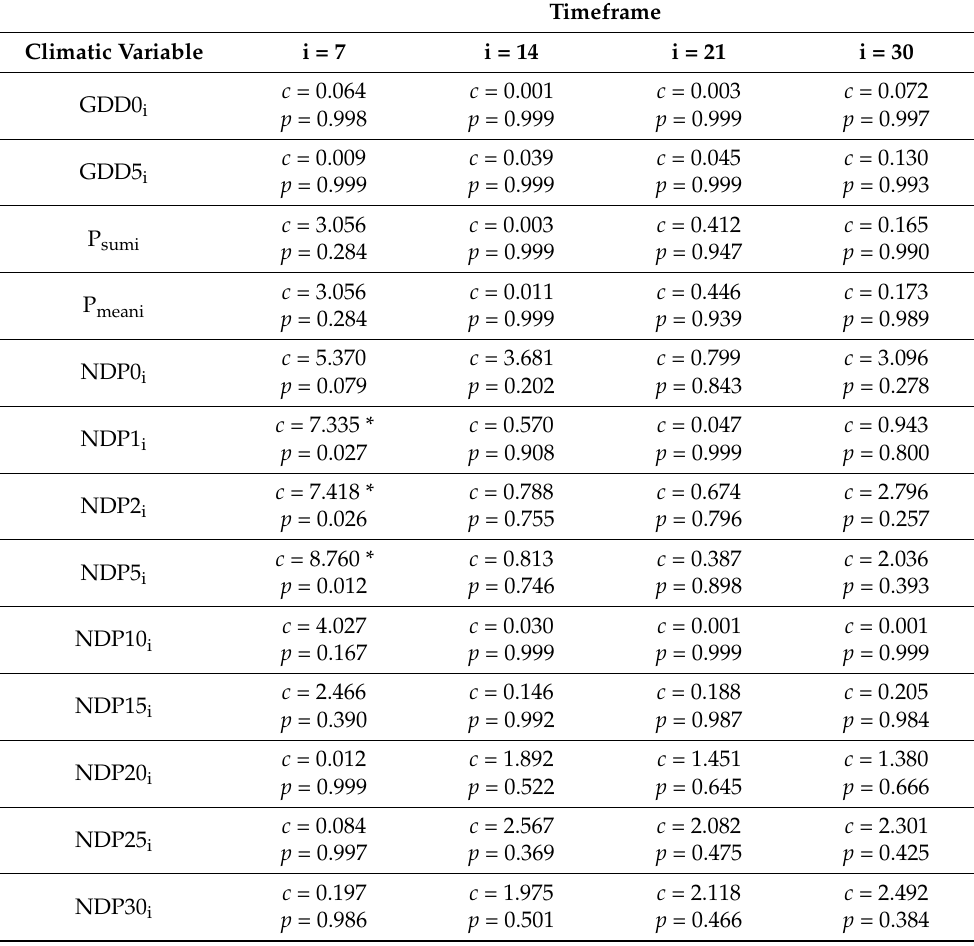
Table 1. Results from unbiased recursive partitioning tree models testing the association between the standardized spore deposition rate (SDR) of Cryphonectria parasitica and the climatic variables. For each climatic variable and associated timeframe (i in days prior to samplings), the c statistics are reported with corresponding p -values. The * symbol indicates significant c values, namely significant associations between the SDR and the climatic variable ( p <